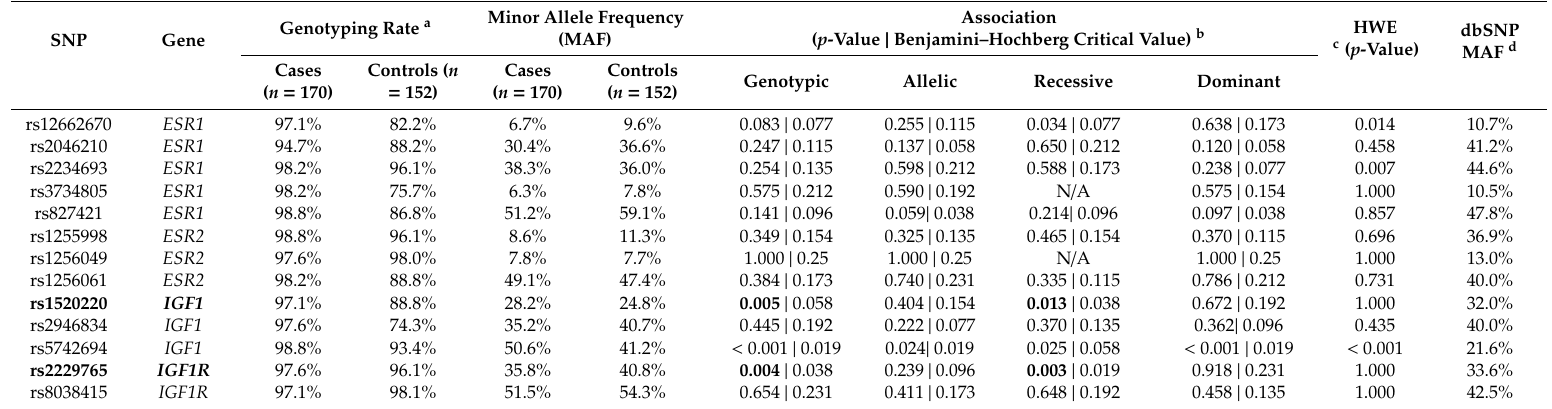
Table 3. Association of the 13 SNP candidates with melanoma in the Genes, Environment, and Melanoma (GEM)